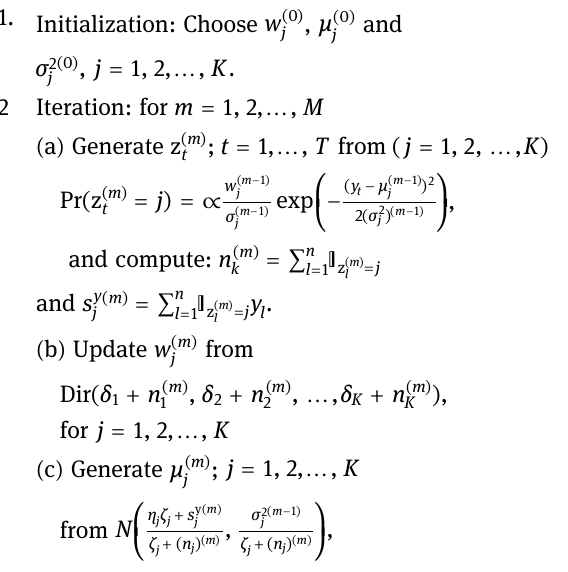
Algorithm 1 : Gibbs sampler for K - component normal mixture